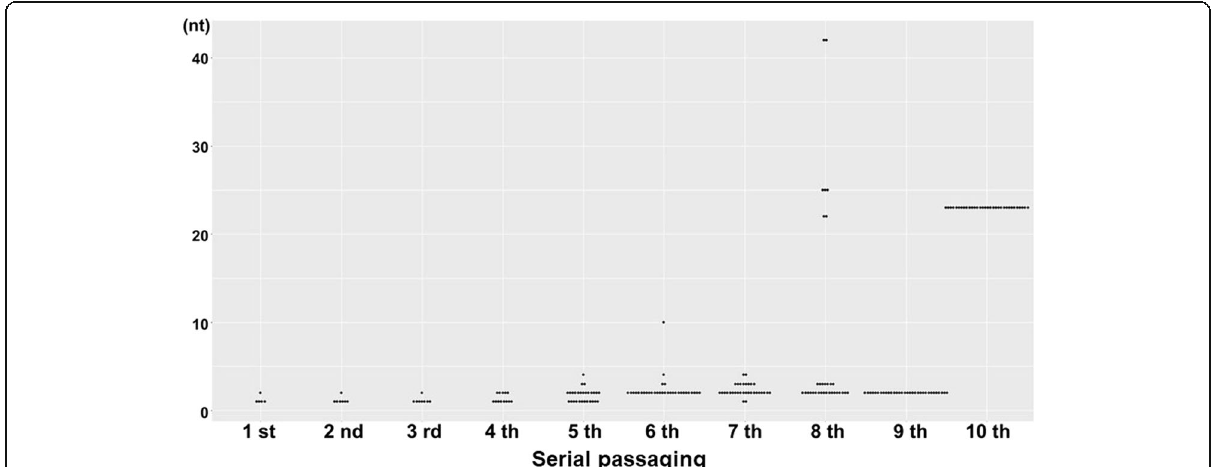
Fig. 6 Variation of deletion/mutation nucleotide numbers in the UPD region during 10 rounds of serial passaging of TMV (24A + UPD). The x-axis represents the number of serial passaging and the y-axis represents the deleted/mutated nucleotide numbers. The black dots in each round of serial passaging represent the clones with nucleotide deletion/mutation in the sequence downstream of internal poly(A) tract